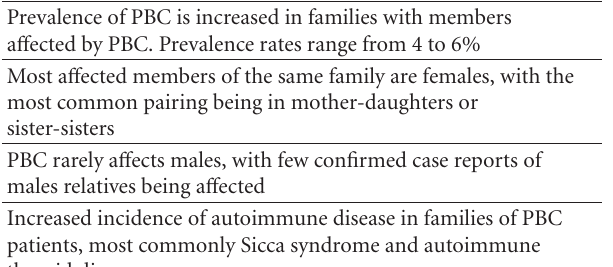
Table 2: Main features of familial Primary Biliary Cirrhosis (PBC). Prevalence of PBC is increased in families with members a ff ected by PBC. Prevalence rates range from 4 to 6% Most a ff ected members of the same family are females, with the most common pairing being in mother-daughters or